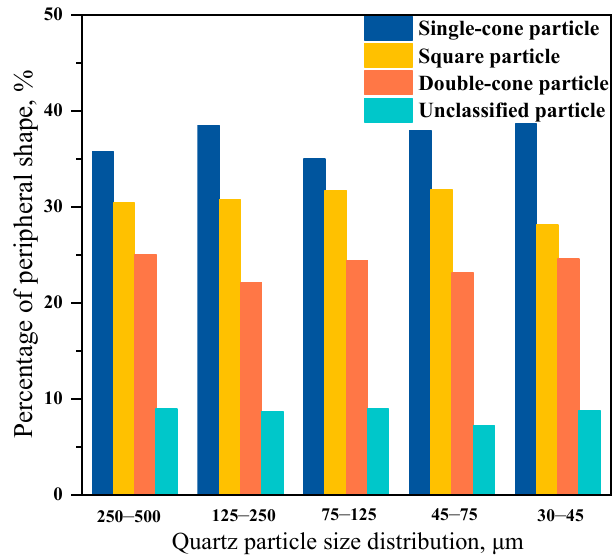
Figure 3. Statistical analysis of the quartz particles’ morphology type.